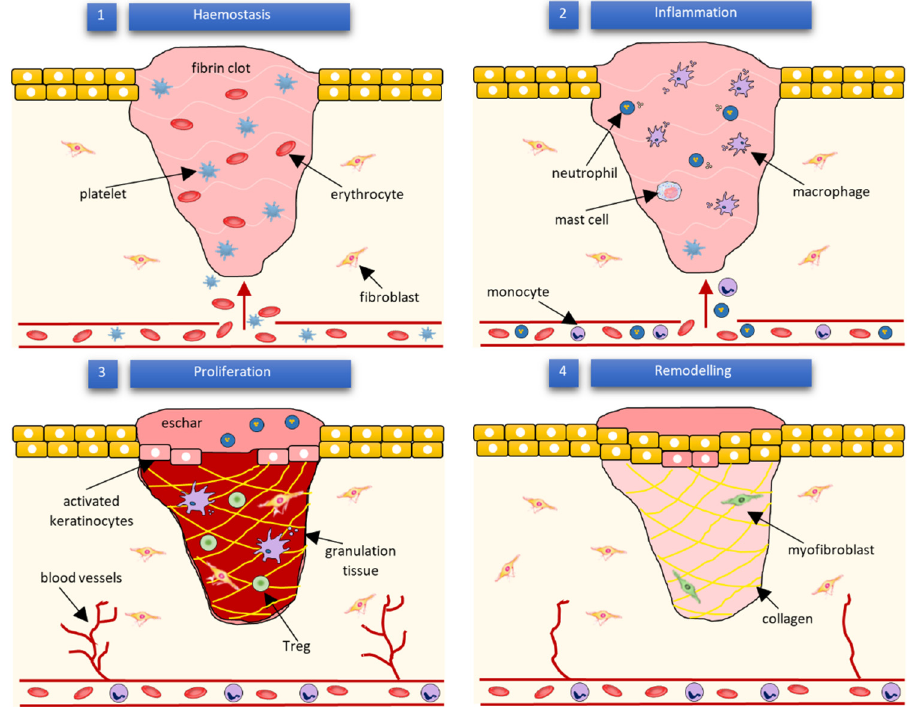
Figure 2. Subsequent phases of wound healing and their main cellular components according to Wilkinson and Hardman [13].